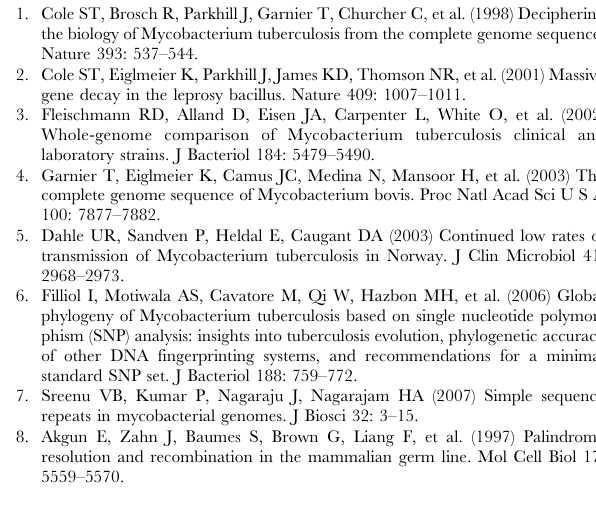
Figure S6 Precise deletions and SSA. M. smegmatis D RecBCD strains process precise deletions between DRs with similar efficiencies as the wild-type strain. Panel A and B , x-axis , M. smegmatis strains; y-axis , frequencies of Hyg R CFUs. Panel A , x-axis , wt/pC E , wild-type/pMV206KmHyg::Gm (control); wt/pDR E A , wild-type/